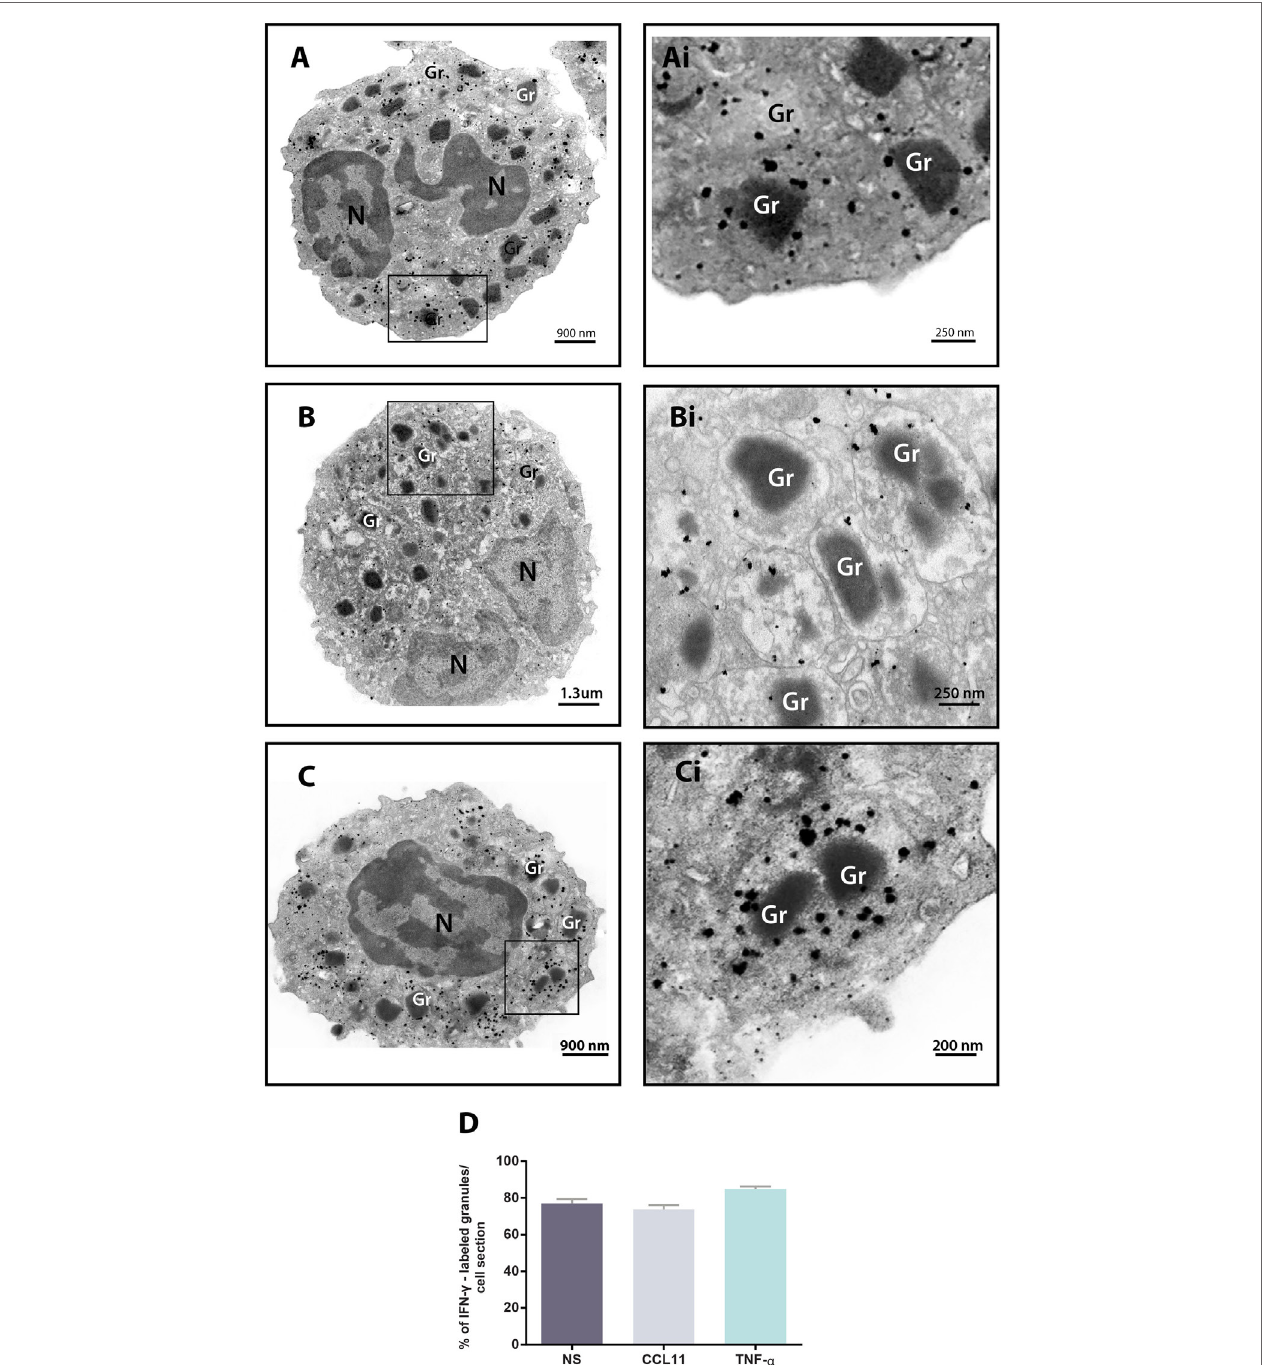
FigUre 3 | Immunolocalization of IFN- γ in unstimulated and stimulated human eosinophils. (a–c) Single-cell analyses at high-resolution reveal a robust labeling of IFN- γ within secretory granules of unstimulated (a) and CCL11- (B) and tumor necrosis factor alpha (TNF- α )- (c) activated eosinophils. The boxed areas in (a–c) are shown at higher magnification in (ai–ci) . Gr, secretory granule. N, nucleus. (D) More than 70% of the granules were positive for IFN- γ . Data represent mean ± SEM. NS, not stimulated. Cells were isolated from the peripheral blood, stimulated or not with CCL11 or TNF- α , and prepared for pre-embedding immunanogold